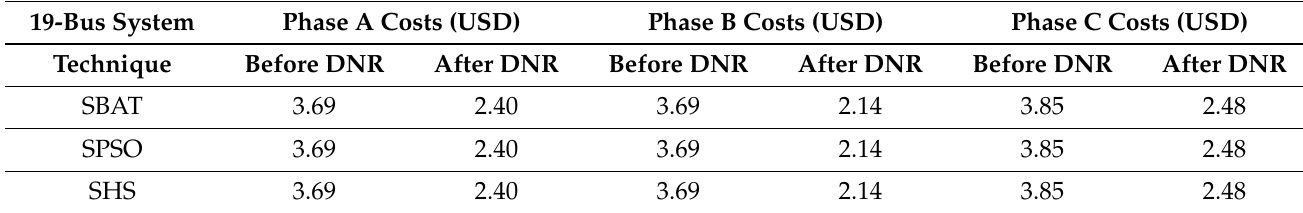
Table 11. Total costs per phase in 24 h (19-bus system/variable